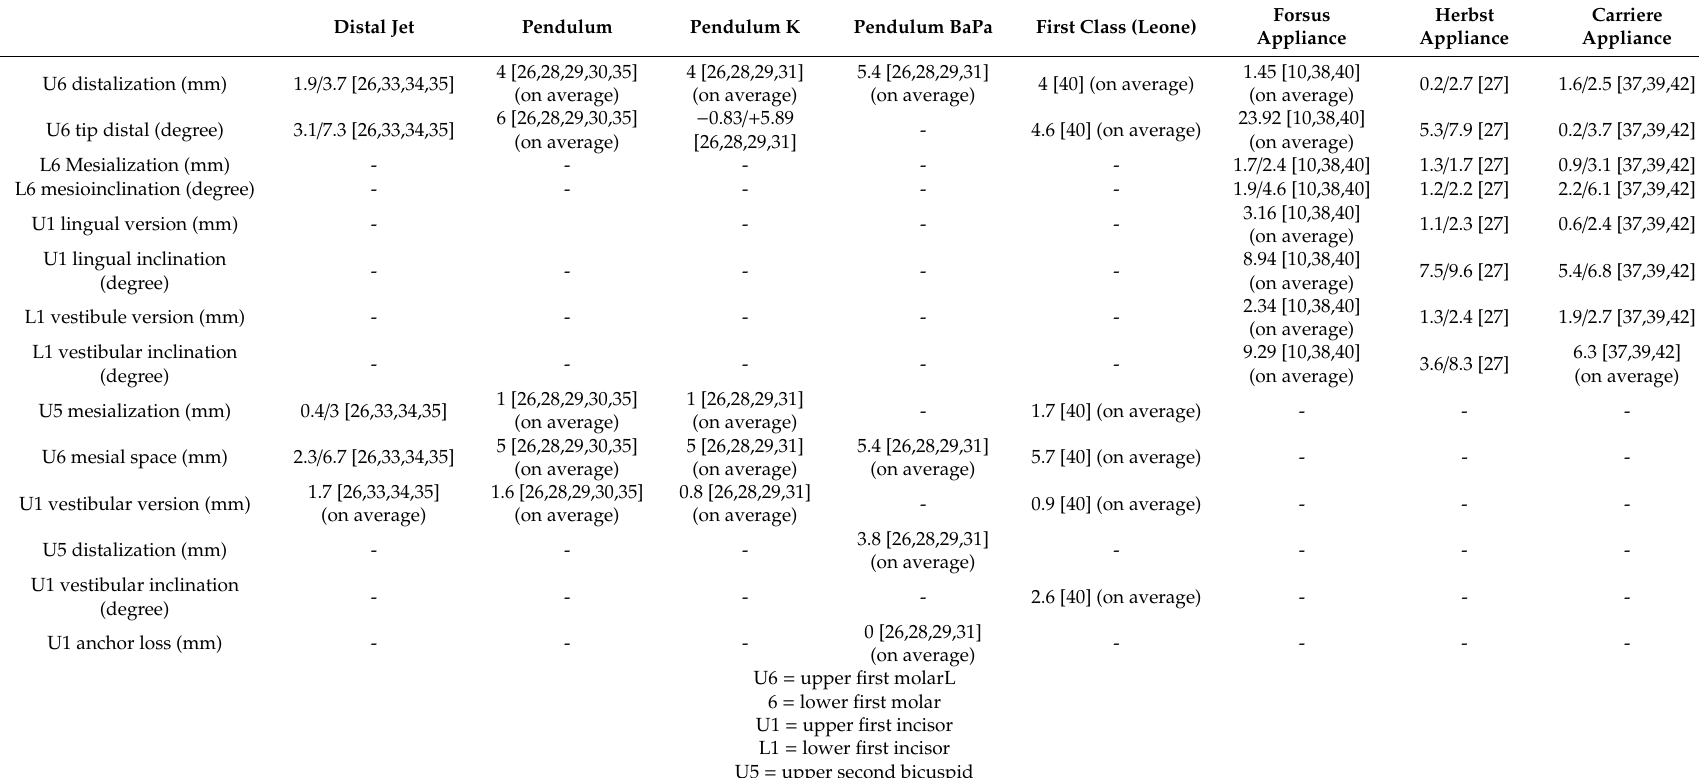
Table 1. Results of the various